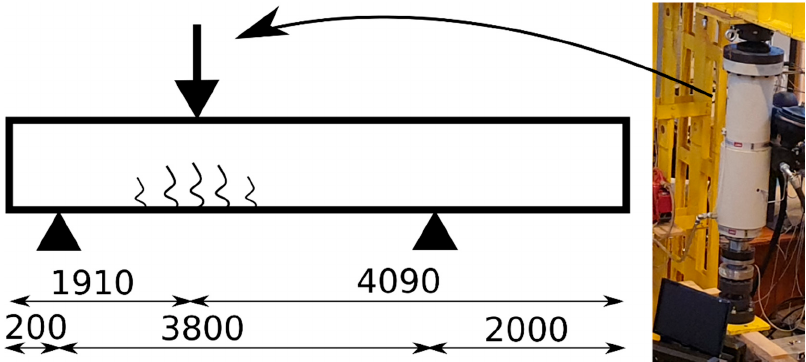
Figure 3. A sketch showing the infliction of damage to the beams using an Instron actuator (photograph on the right). Dimensions in mm.